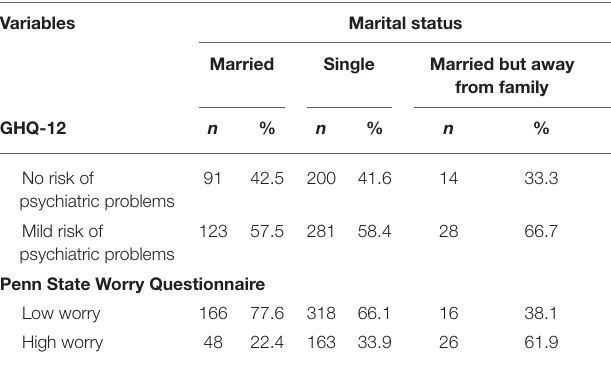
TABLE 3 | The prevalence of mild risk of psychiatric problems and worry across marital status during the COVID-19 pandemic.